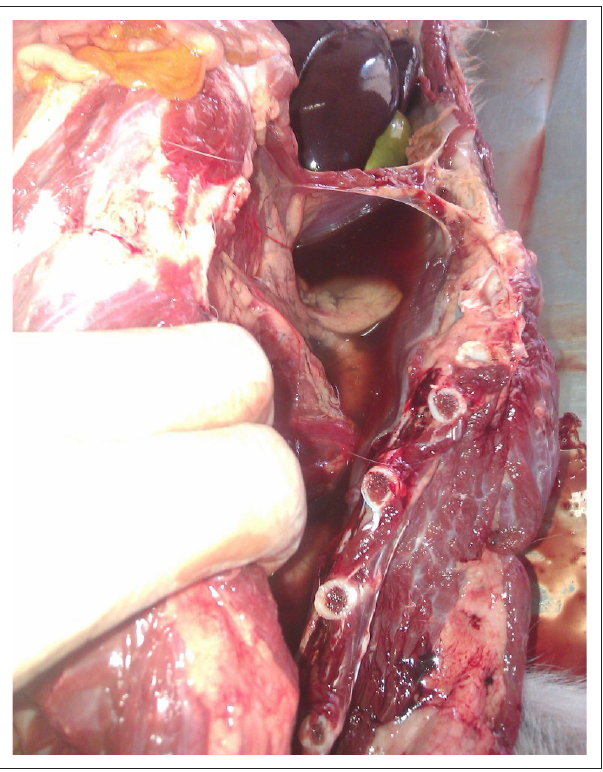
FIGURE 2: Ventro-cranial view of the opened thorax showing severe hydrothorax.